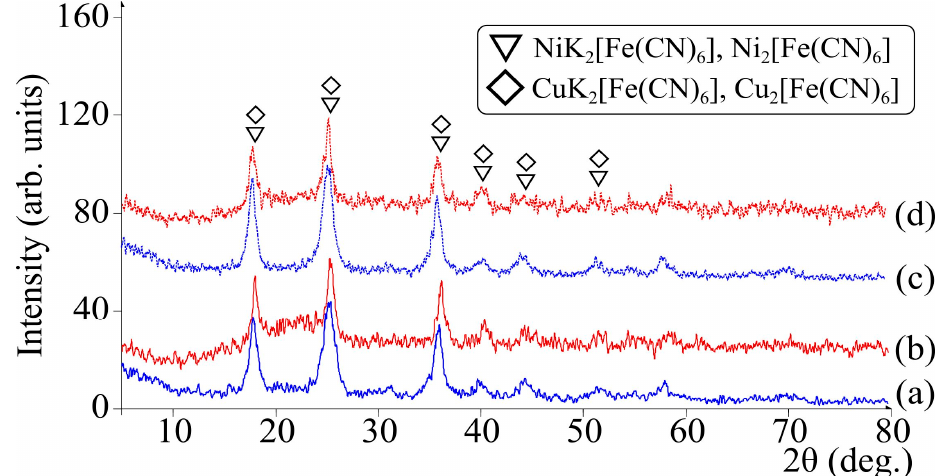
Figure 4. XRD patterns of the samples: initial powders ( a ) FOC K-Ni, ( b ) FOC K-Cu; and chitosan- based hybrids ( c ) CS/FOC K-Ni, ( d ) CS/FOC K-Cu.